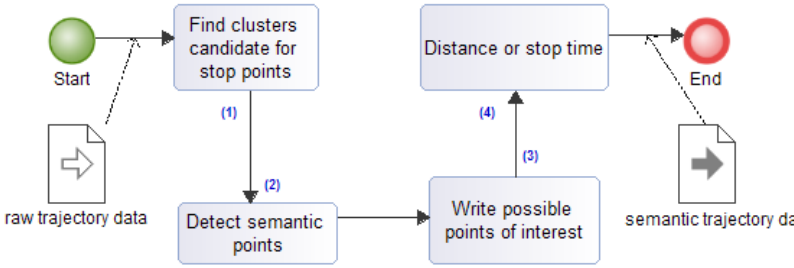
Figure 8. Semantic Enrichment performed by the